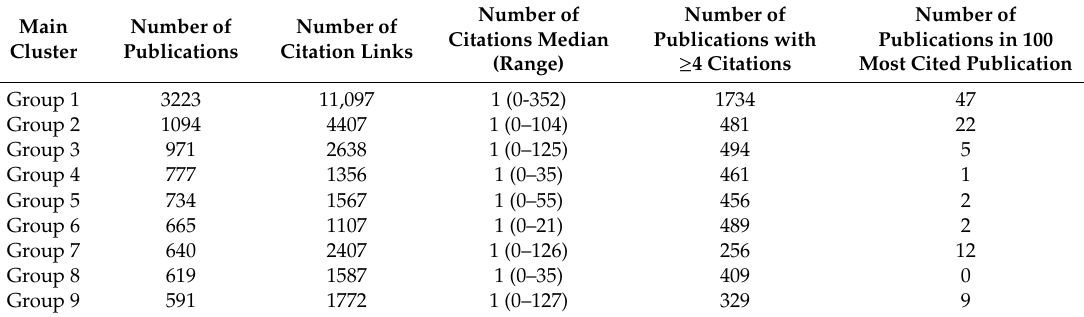
Table 2. Citation network information on the nine main